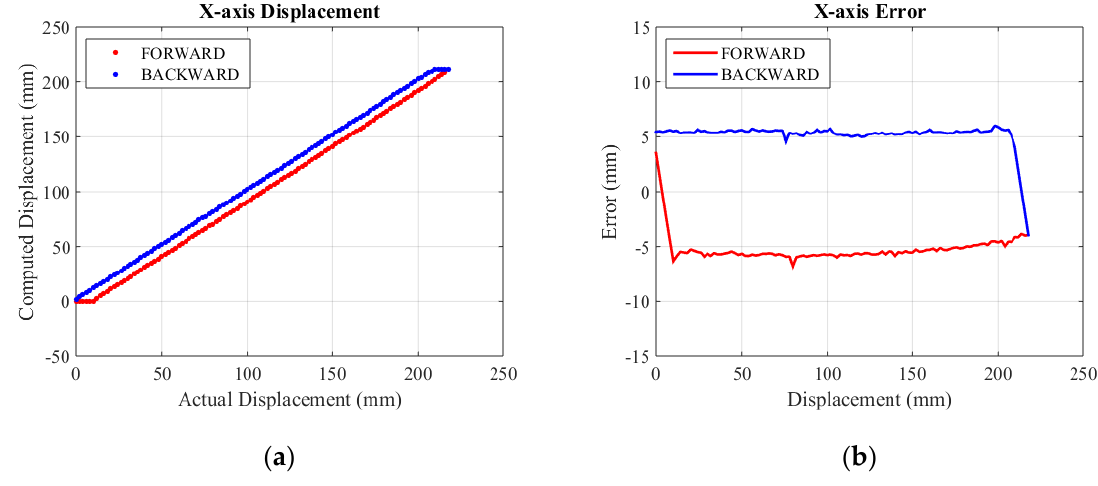
Figure 13. X-axis displacement and error. ( a ) Displacement ; ( b ) Error.